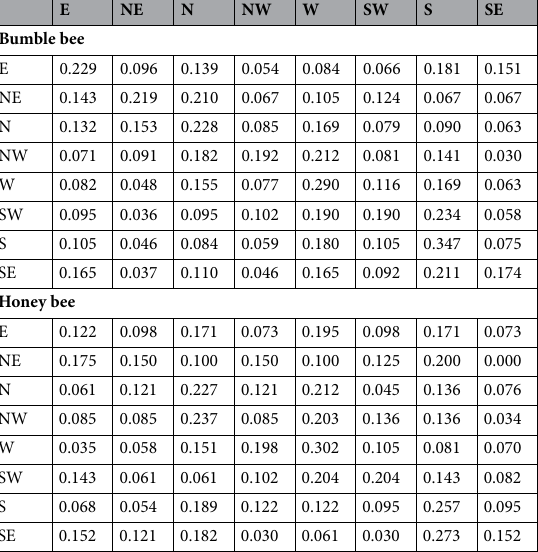
Table 4. Transition matrix for (a) bumble bee and (b) honey bee. Each cell in the matrix represents the probability that a bee moves from one direction to the next. For example, bumble bees have a 0.229 probability of moving from East to East and a 0.096 probability of moving from East to North